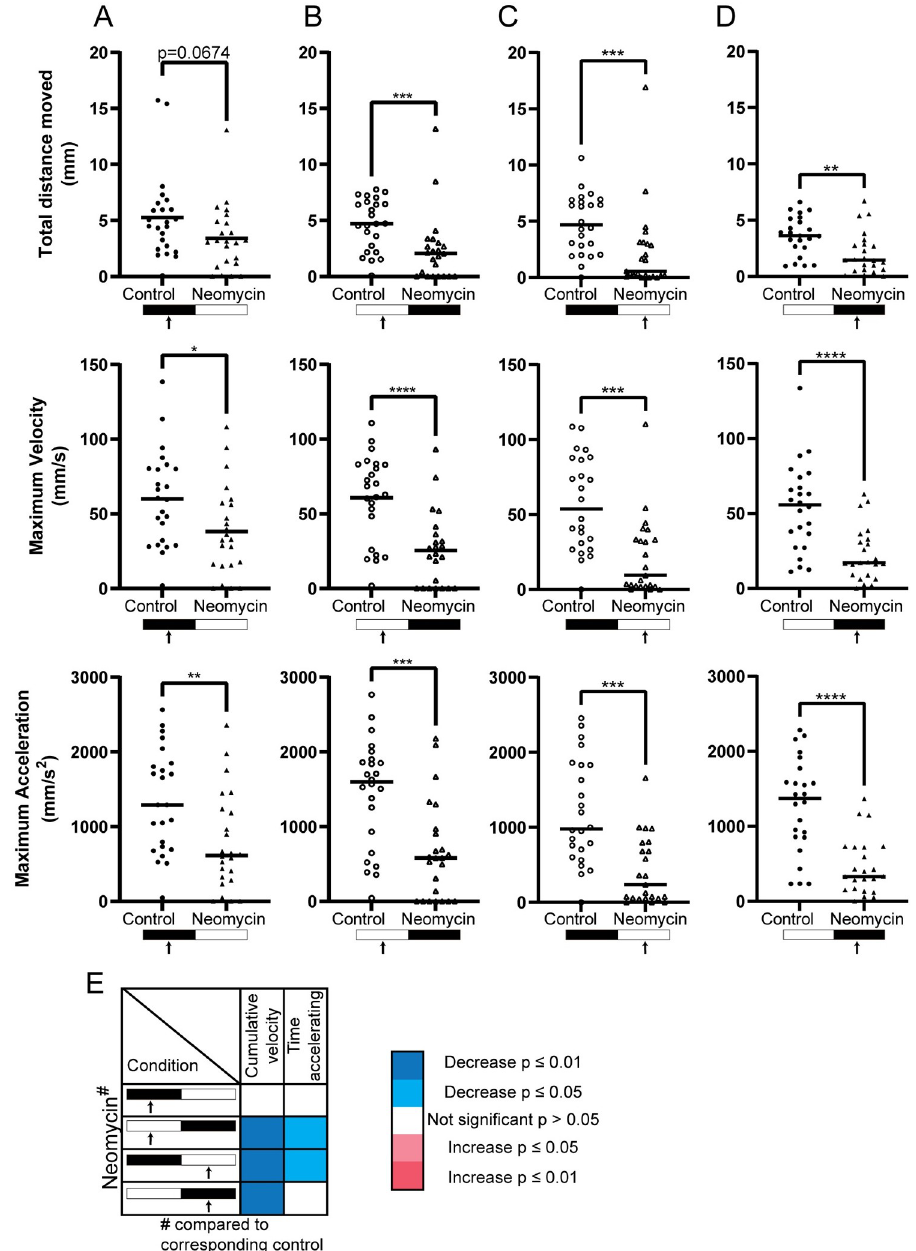
Fig 4. Neuromast ablated larvae exhibited less startle response compared to control group. (A, B, C, D) Neomycin treated larvae (triangles) had less response to tapping stimulus during 280 ms under both light (open triangles; white) or dark (solid triangles; black) regardless of order. (E) Heatmap representation of other analyzed parameters indicated the differences between control and treated group were evident under light. n = 23–24 per group. Data is presented in scatterplots showing individual values and group mean or median. Significance: � p � 0.05, �� p � 0.01, ��� p � 0.001, ���� p �